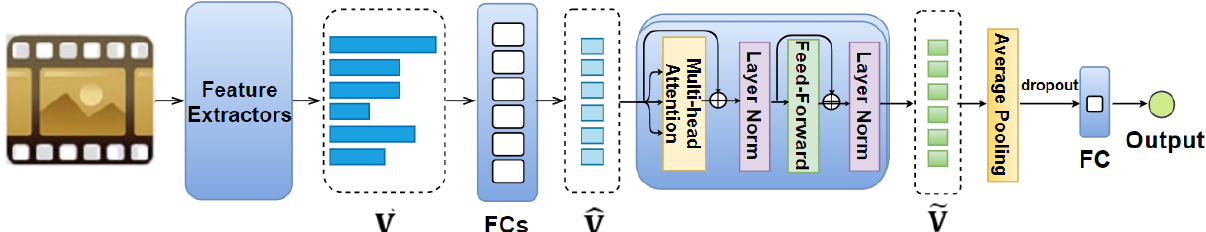
Figure 2. Our proposed Feature AttendAffectNet. For dimension reduction, the set of feature vectors V is fed to fully connected layers with eight neurons each (so as to obtain a set of dimension-reduced feature vectors ˆ V ) before being passed through N identical layers (each layer includes a multi-head self-attention accompanied with a feed-forward layer). The output of such stack is a set of encoded feature vectors ˜V , which are then fed to an average pooling layer, dropout, and a fully connected layer (consisting of one neuron) to obtain the predicted arousal/valence